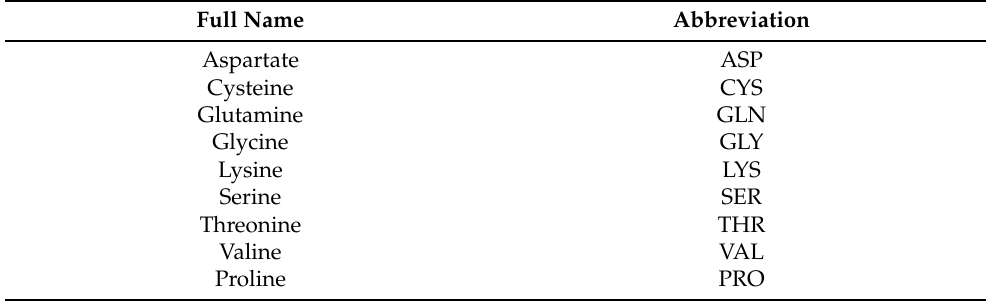
Figure A19. ( A ) Snapshot of DBD15-21-22 simulation with GDP/GTP free KRAS-WT. ( B ) RDF of DBD15-21-22 with water. Table A1. Amino acid compounds of the the KRAS proteins. Abbreviations as used in the text and in several